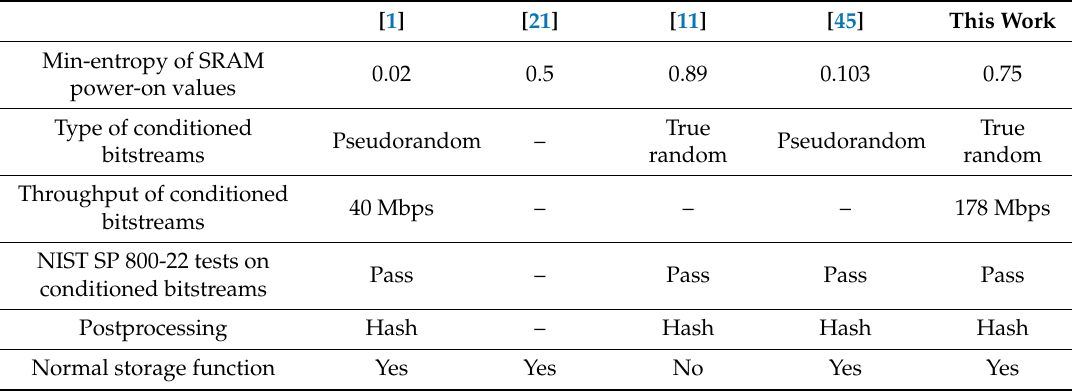
Table 2. Comparison with prior